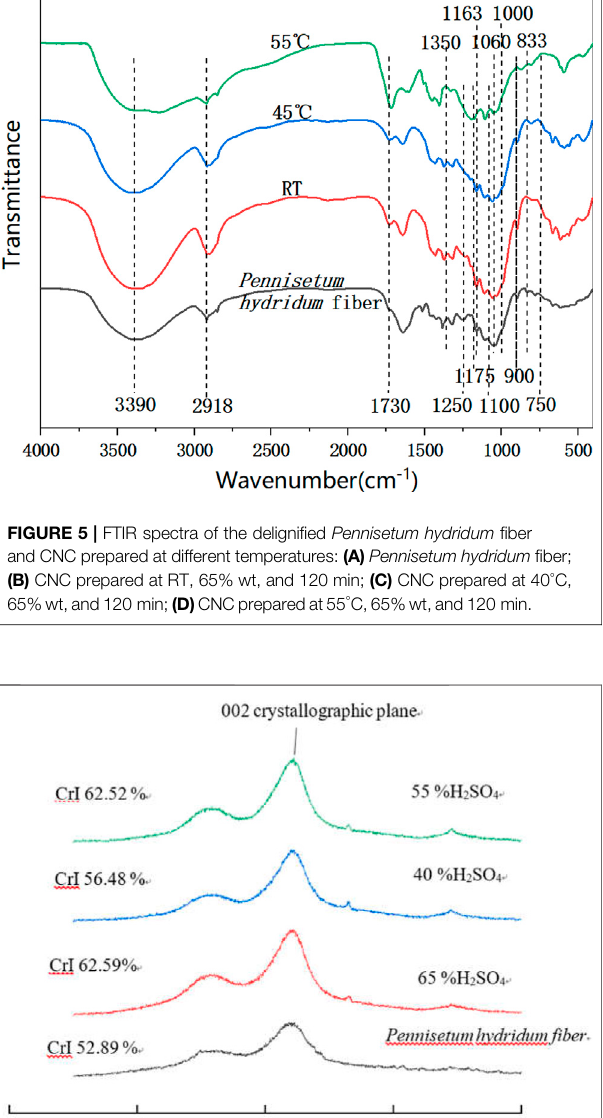
Frontiers in Energy Research |